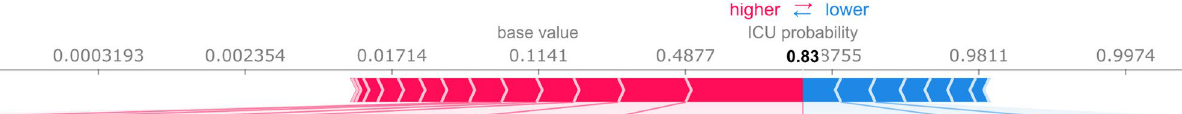
Figure 10. Force plot of SHAP values for a single patient. Less important features are omitted for the sake of visualization. Features are represented as arrows that push the outcome (black small vertical line), either towards a ICU outcome (red arrows) or a non-ICU outcome (blue arrows). The black number over the small vertical line, 0.83, is the probability of the outcome for this patient. The length of the arrows is proportional to the SHAP values of the associated features for this particular prediction. Under each arrow it is reported the corresponding feature name and value. More details in the